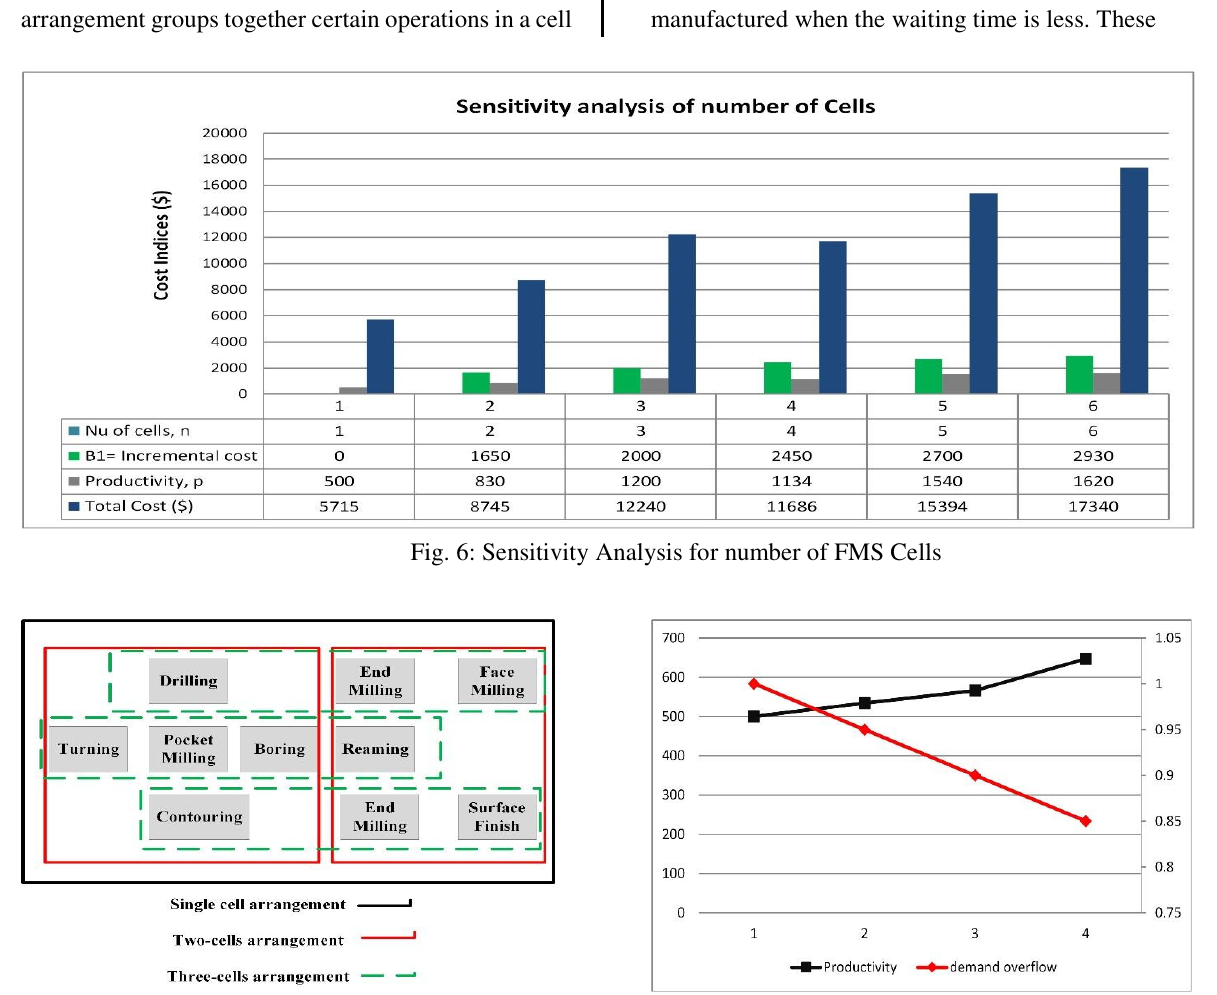
. Fig. 7: Multiple cellular arrangements of FMCs Fig. 8: Product Overflow